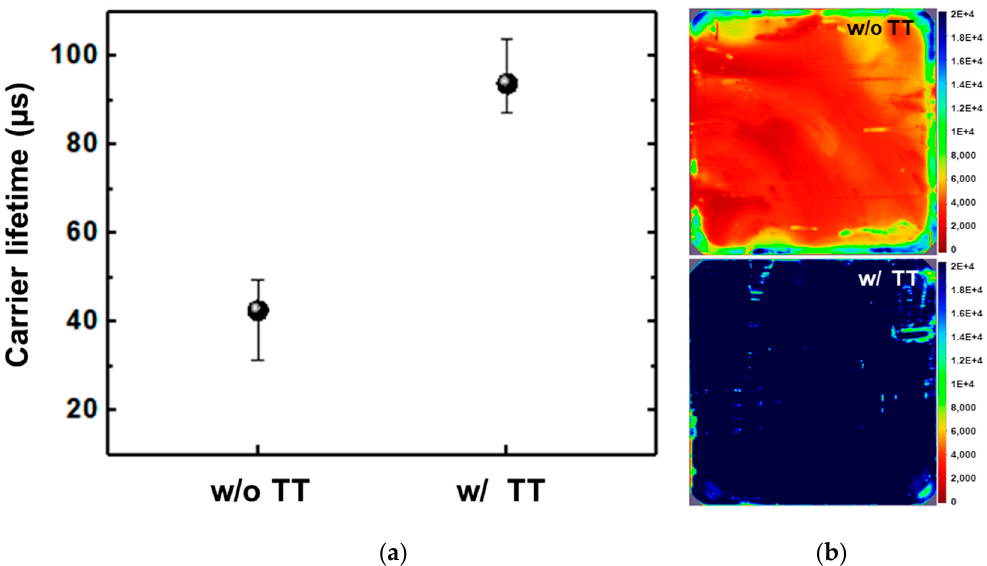
Figure 2. Measurement of bulk lifetime via saw damage gettering (SDG) before and after TT: ( a ) QSSPC; ( b ) PL images.